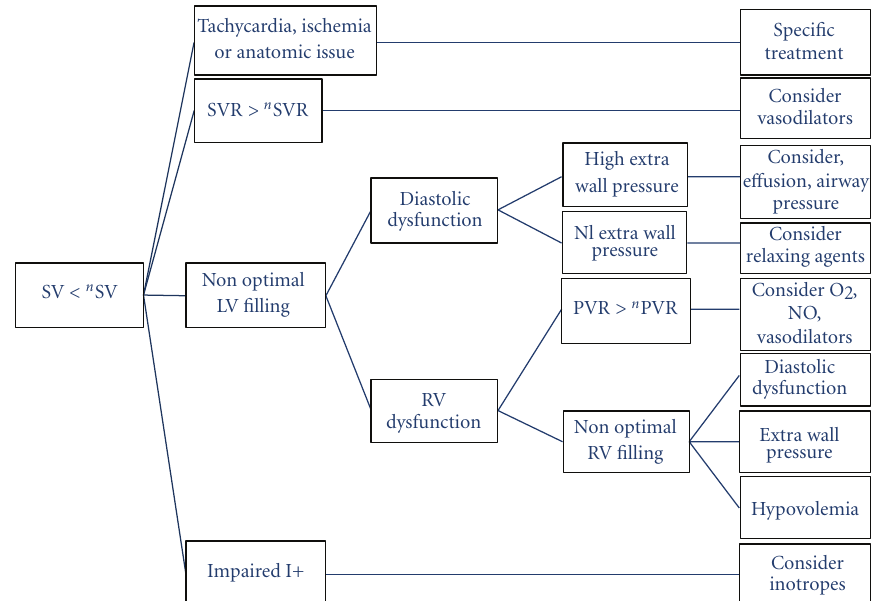
Figure 2: Subsequent algorithm dedicated to SV analysis. The needed SVR is that specific value of SVR allowing the generation of the minimum blood pressure (usually set at a mean value of 65 mmHg) with the needed CO. Similarly for needed PVR.